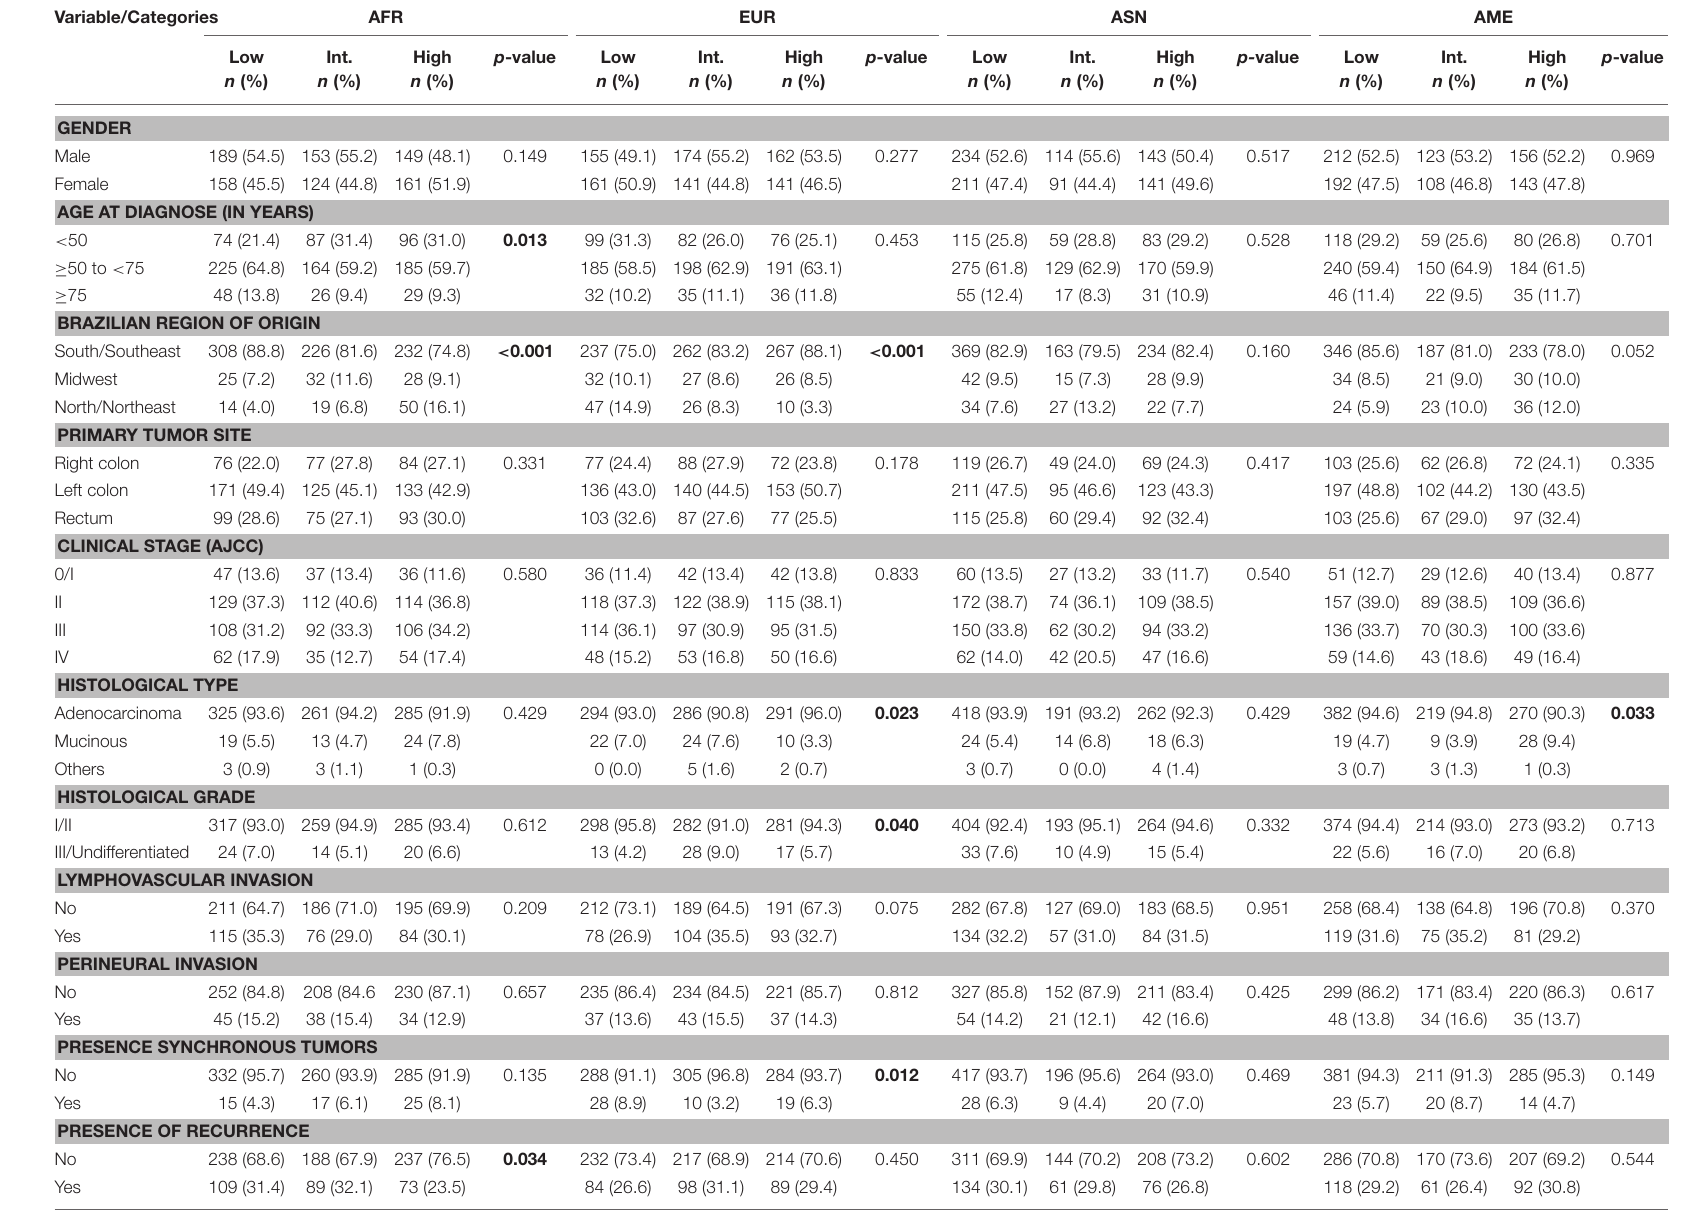
Significant associations are indicated in